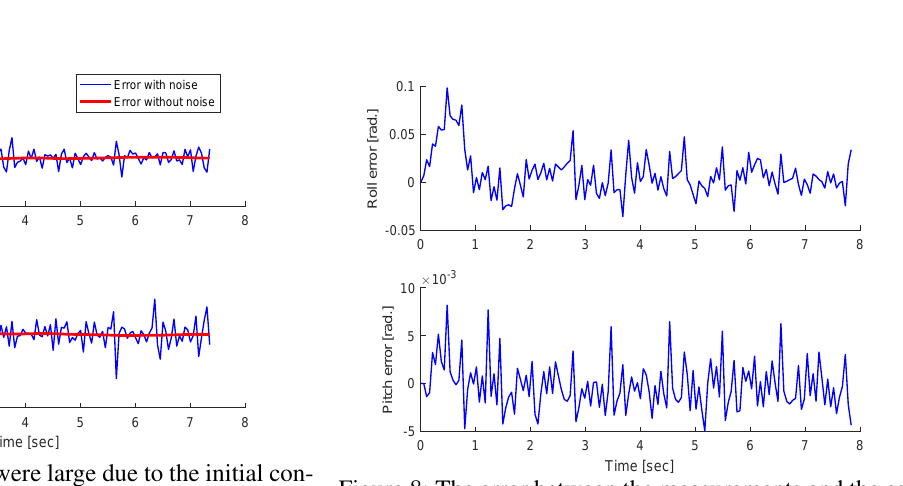
Figure 8: The error between the measurements and the esti- mates of the roll case.